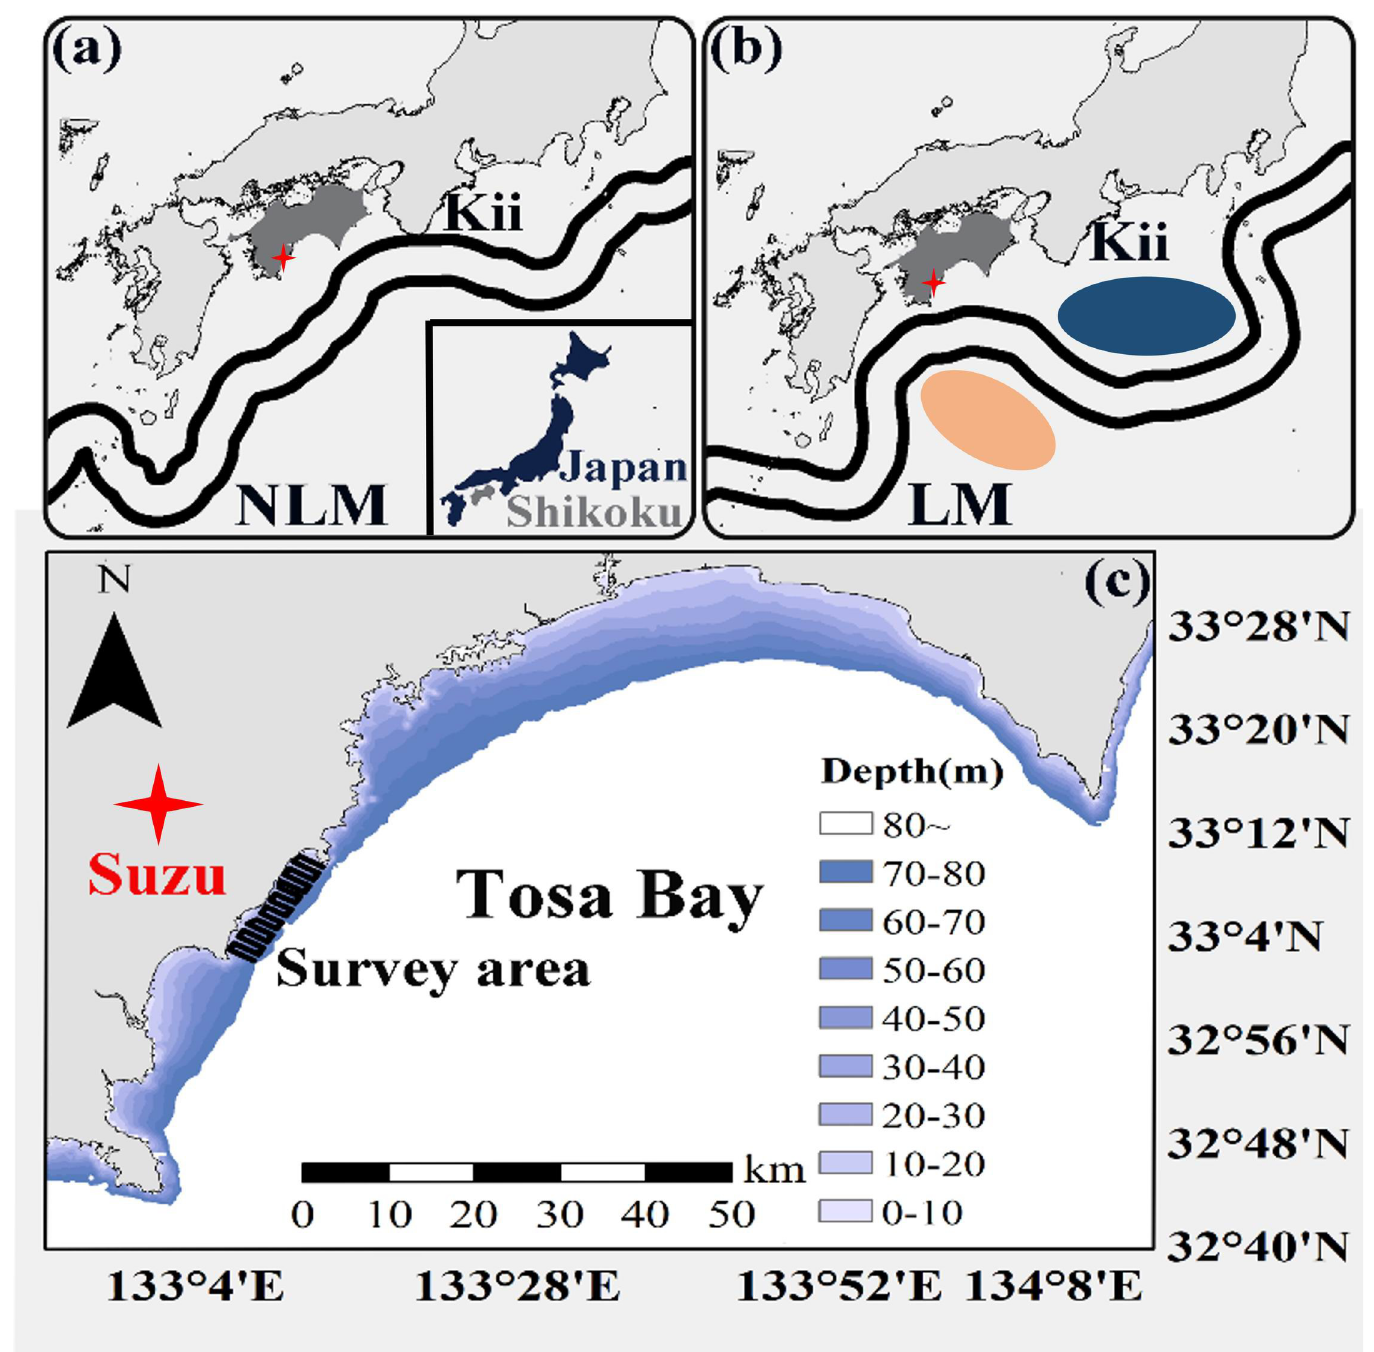
Fig 1. (a), (b) Two typical paths of the Kuroshio south of Japan: the offshore non-large meander (NLM) path on February 8, 2017, and the large meander (LM) path on February 25, 2018; based on the data from Hydrographic and Oceanographic Department Japan Coast Guard (JCG: https://www1.kaiho.mlit.go.jp/jhd.html). Blue cold water mass and pink warm water mass were modified from Miyama (2019) [9]. (c) The study area and survey line. The solid line shows the hydro acoustic transects, with a total length of 64 km. The triangle marks the location of the set net.